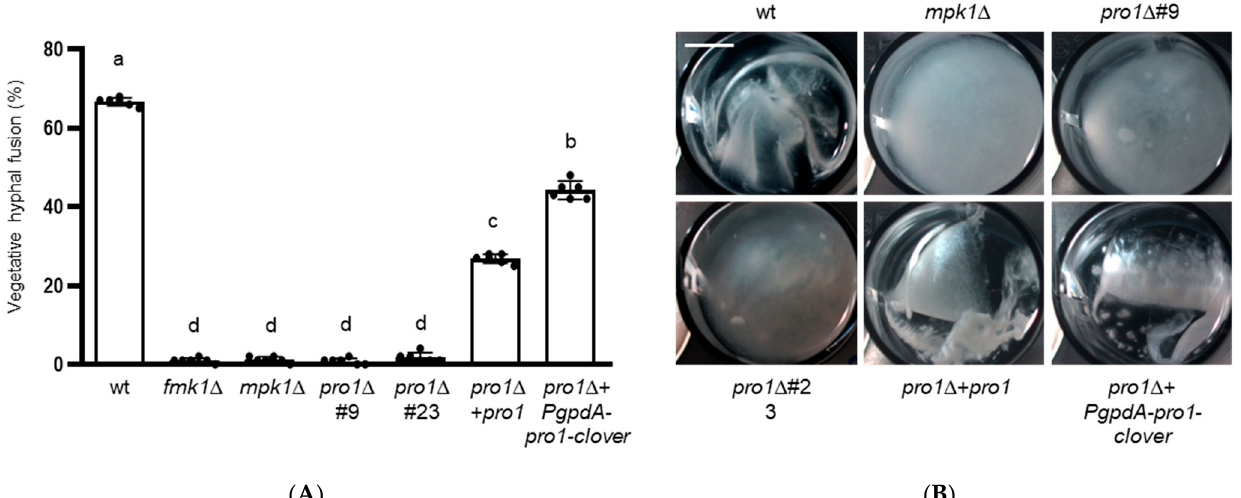
Figure 2. Pro1 is required for vegetative hyphal fusion and mycelial aggregation. ( A ) Microconidia of the indicated strains were germinated on water agar plates supplemented with 25 mM NaNO 3 . After 15 h the percentage of germ tubes undergoing vegetative hyphal fusion was determined. Data show means ± s.d. Columns with the same letter are not significantly different according to one-way ANOVA followed by Tukey’s multiple comparison test ( p < 0.05). ( B ) Formation of hyphal aggre- gates after 36 h growth in minimal medium supplemented with 25 mM NaNO 3 . Fungal cultures were vortexed to dissociate weakly adhered hyphae, transferred to a multiwell plate and imaged under a Lumar V12 stereomicroscope equipped with an AxioCam MR5 camera.